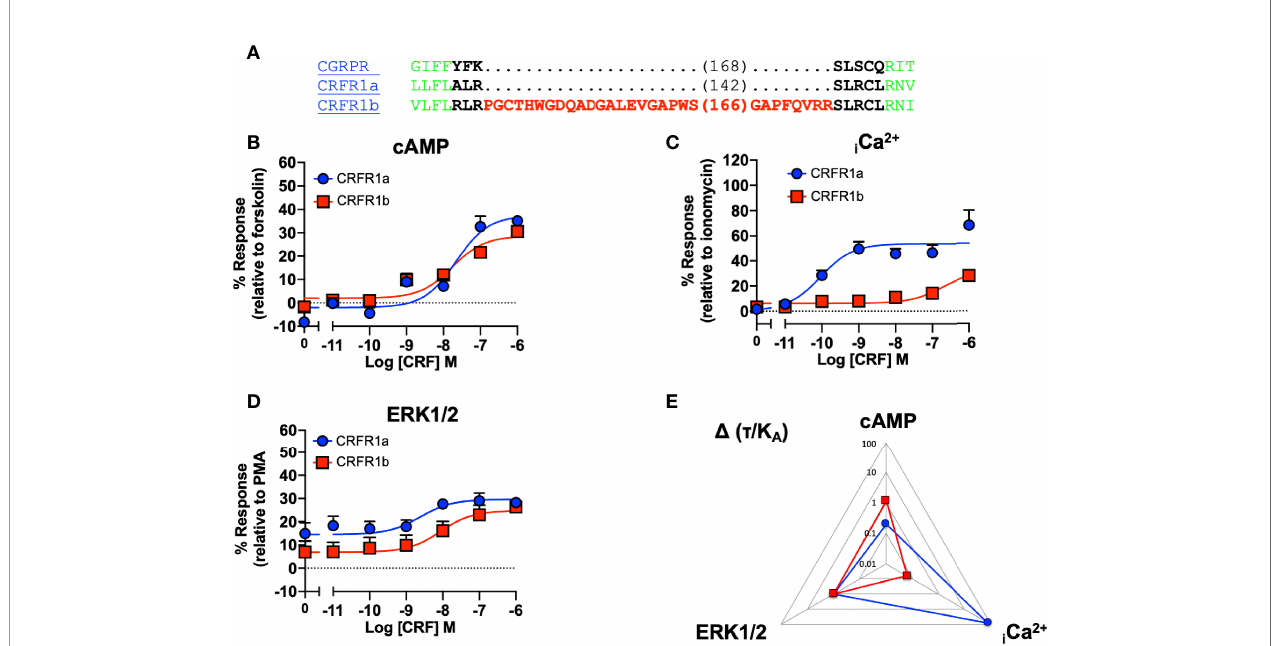
FIGURE 7 | Signaling bias of splice variants of ICL1 at the CRF receptor. (A) Sequence of CRFR1 splice variants, with CGRPR as reference. Splice variants of the CRFR1 were compared for (B) cAMP production, (C) elevation of i Ca 2+ , (D) ERK1/2 phosphorylation. (E) Signaling bias plot was calculated as 10 D ( t /KA) for each mutant and each signaling pathway relative to ERK1/2 phosphorylation. All data are mean ± SEM of n repeats where n=minimum of 3 triplicates.